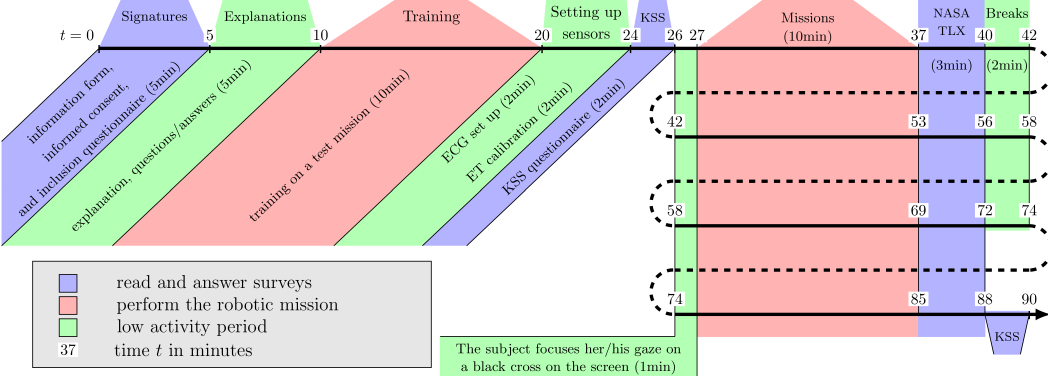
Figure 2. Experimental protocol time